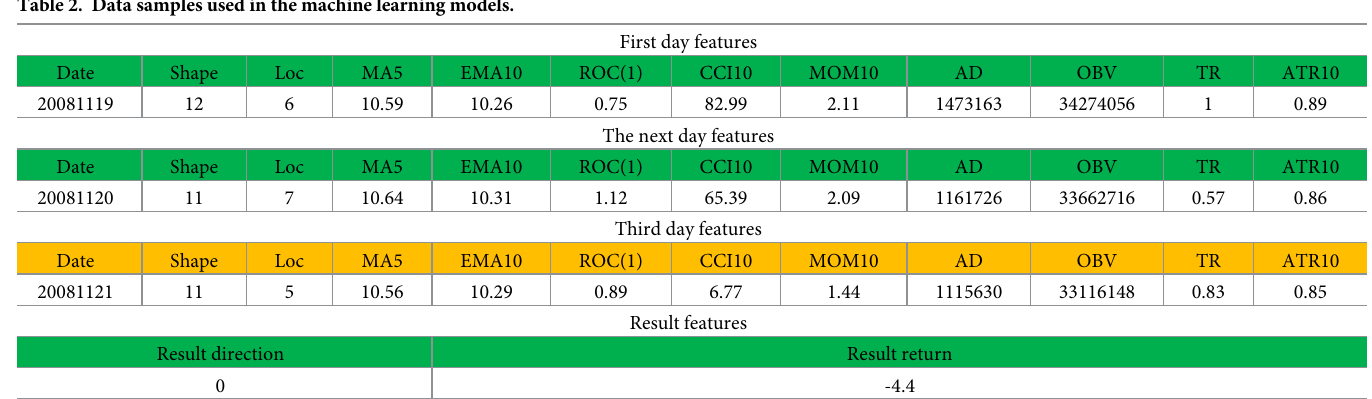
Table 2. Data samples used in the machine learning models.